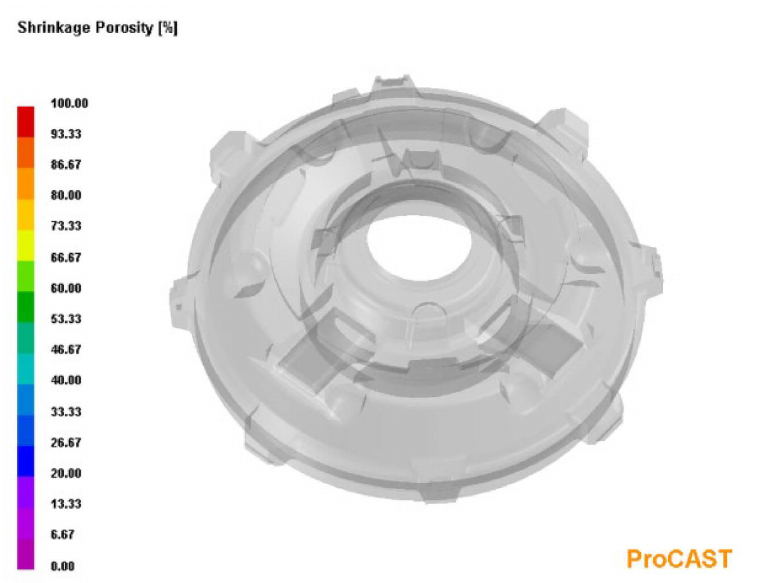
Figure 13. Distribution of microporosity in casting, with a large number of nucleation sites of primary